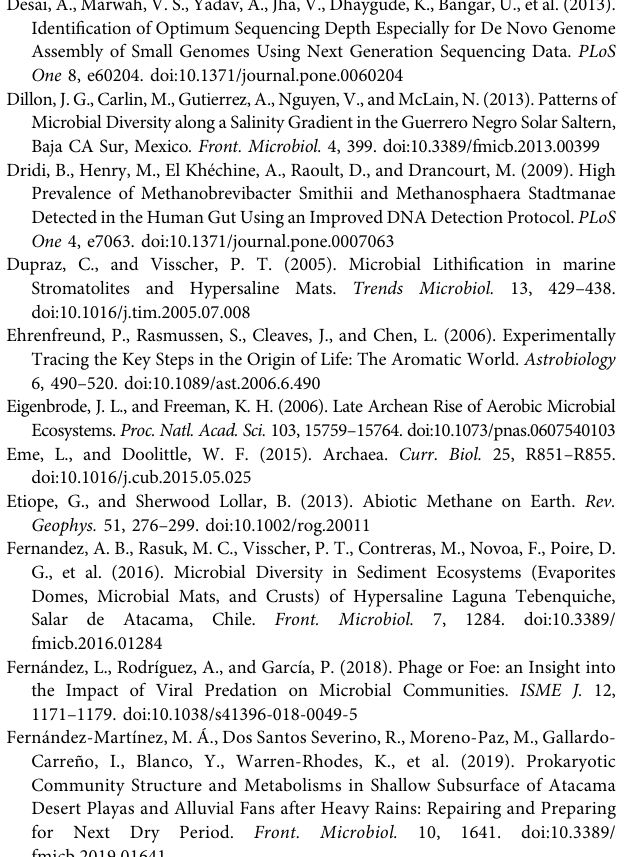
Table 1. J. Clin. Microbiol. 51, 993 – 994. doi:10.1128/jcm.02863-12 Brochier-Armanet, C., Boussau, B., Gribaldo, S., and Forterre, P.